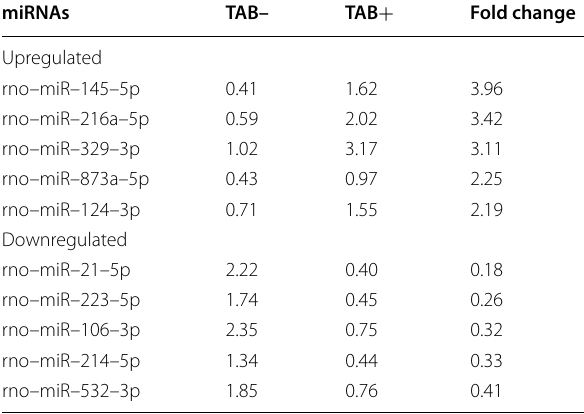
Table 3 Differentially expressed miRNAs (fold change > 2 or